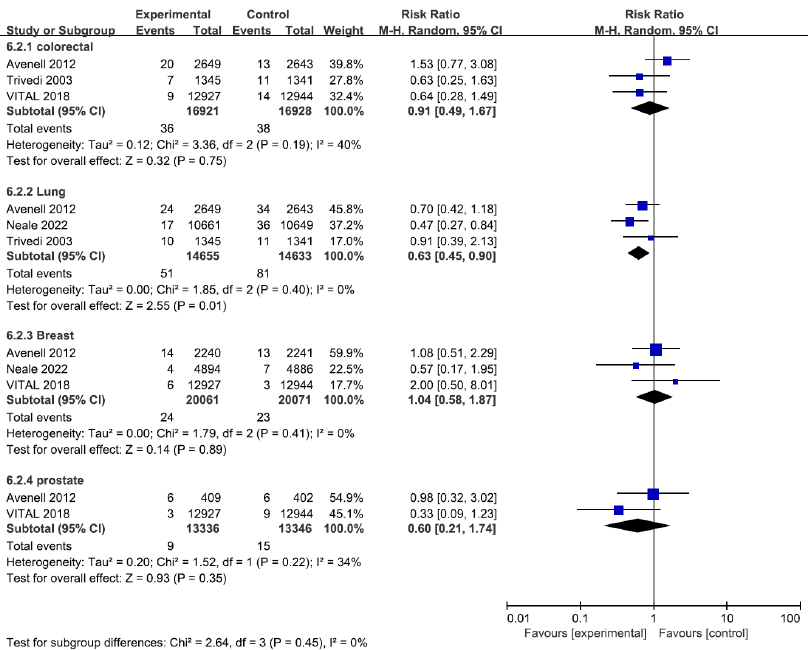
Figure 3. The forest plot of vitamin D supplementation and site-specific cancer